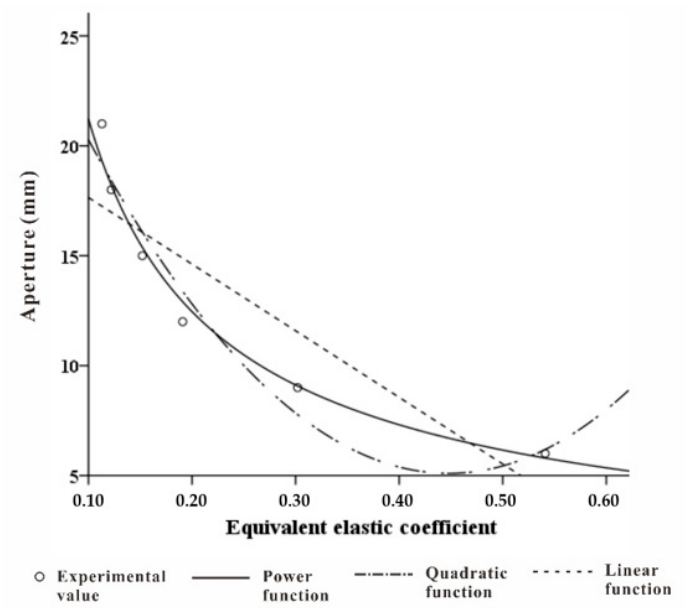
Figure 9. Pore diameter-equivalent elastic coefficient regression curve.